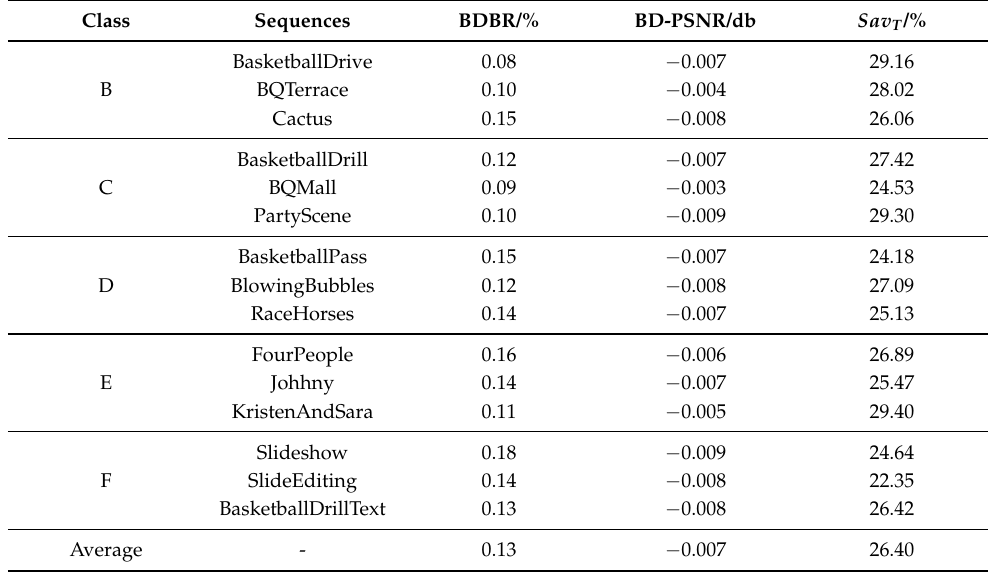
Table 6. The proposed algorithm compared to the original VVC experimental